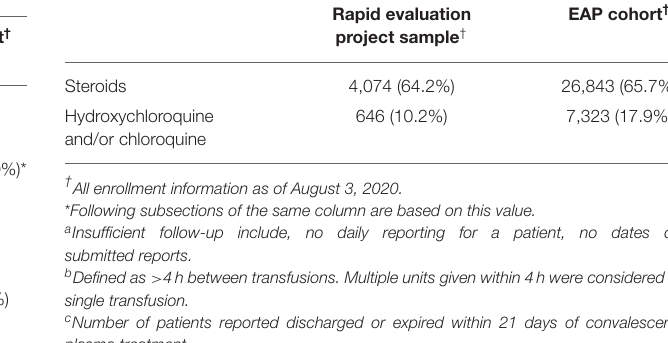
TABLE 1 | Demographic factors and disease severity in patients in the Rapid Evaluation Program and the overall expanded access program †